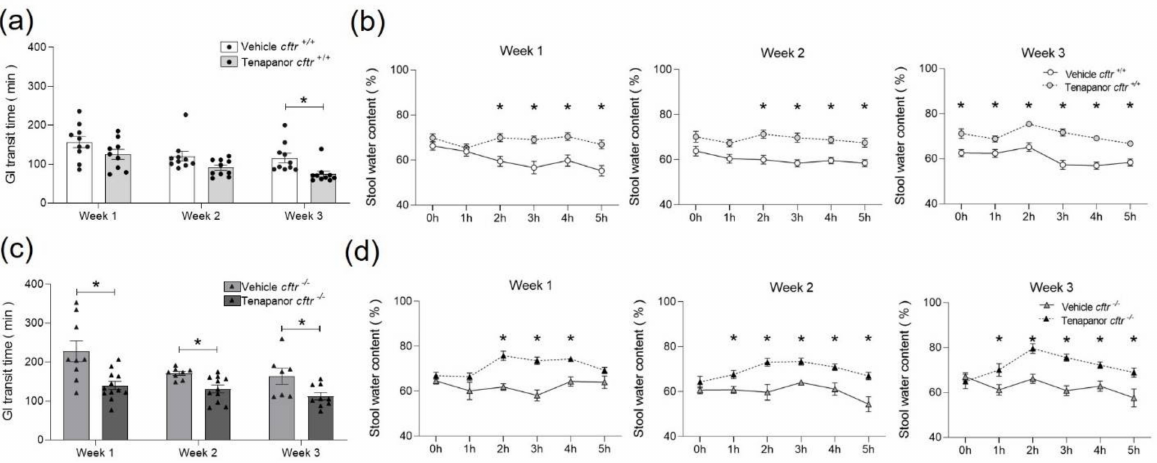
Figure 2. Faster GI transit time (GTT) in tenapanor-treated mice. ( a , c ) GTT was measured once per week, and it decreased in both cftr +/+ and cftr − / − mice from week 1 to week 3 and was decreased after gavage with tenapanor compared to vehicle. ( b , d ) The longitudinal assessment of the stool water content during the 5 h post-gavage showed a significant increase with tenapanor compared to vehicle treatment. 0 h indicates stool samples collected pre-gavage. Each dot/triangle in the GI transit measurement represents one mouse, with the same mouse then being simultaneously assessed for stool water content. Data are represented as means ± SEM. * p < 0.05.